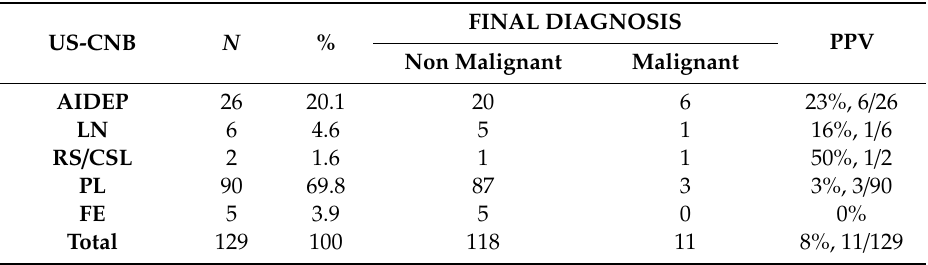
Table 1. Descriptive statistics for histopathological diagnoses among all B3 lesions diagnosed ad US-CNB. Final histologic results for each sub-category and associated positive predictive value (PPV) for breast malignancy.